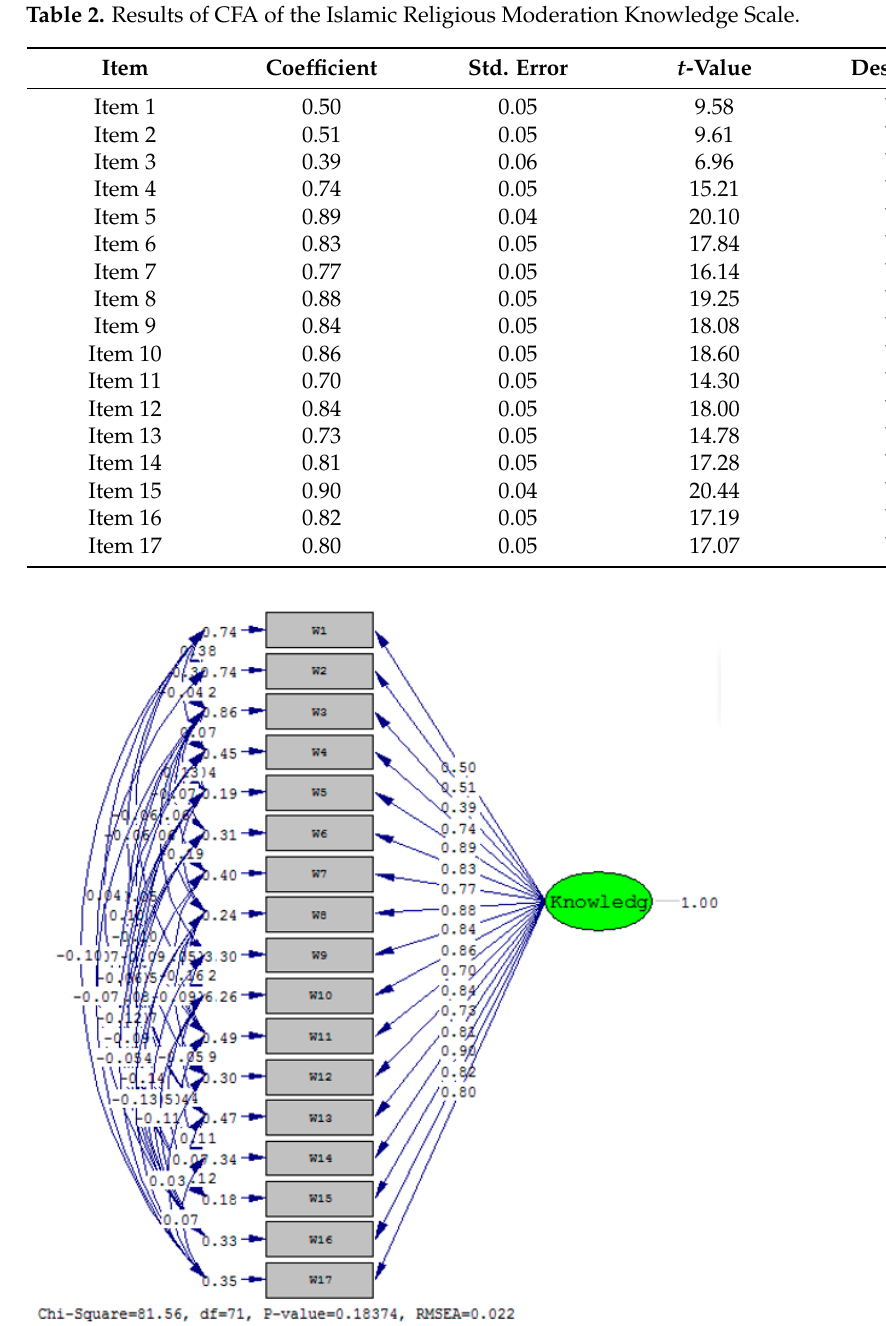
Table 2. Results of CFA of the Islamic Religious Moderation Knowledge Scale.